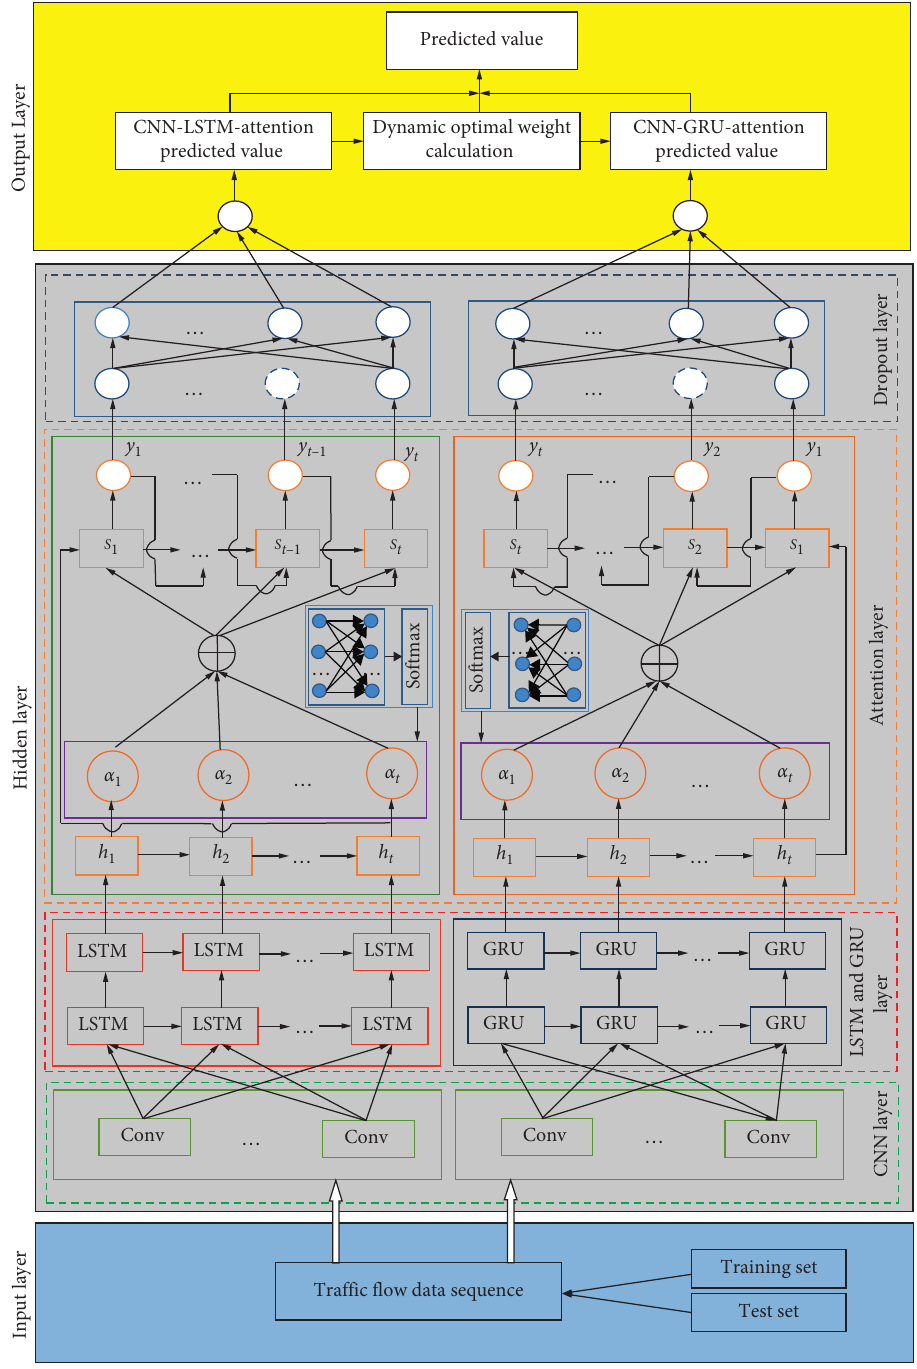
Figure 4: The structure of the CDLP